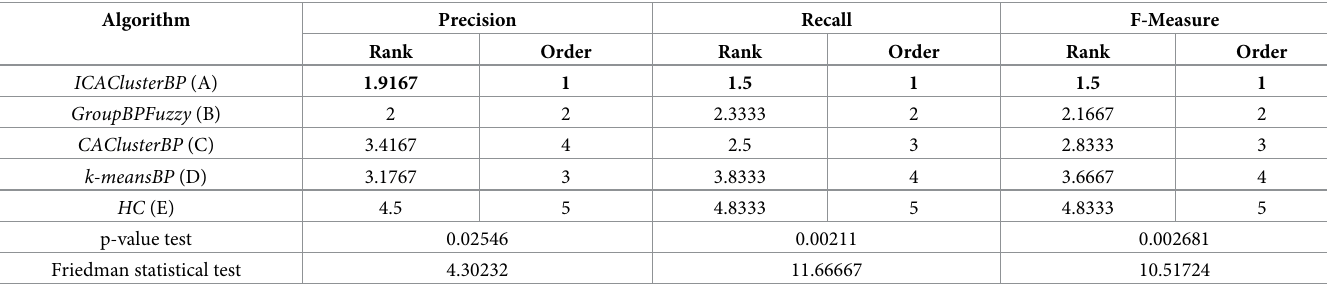
Table 5. Quality of the algorithms classification according to Friedman test (best results in